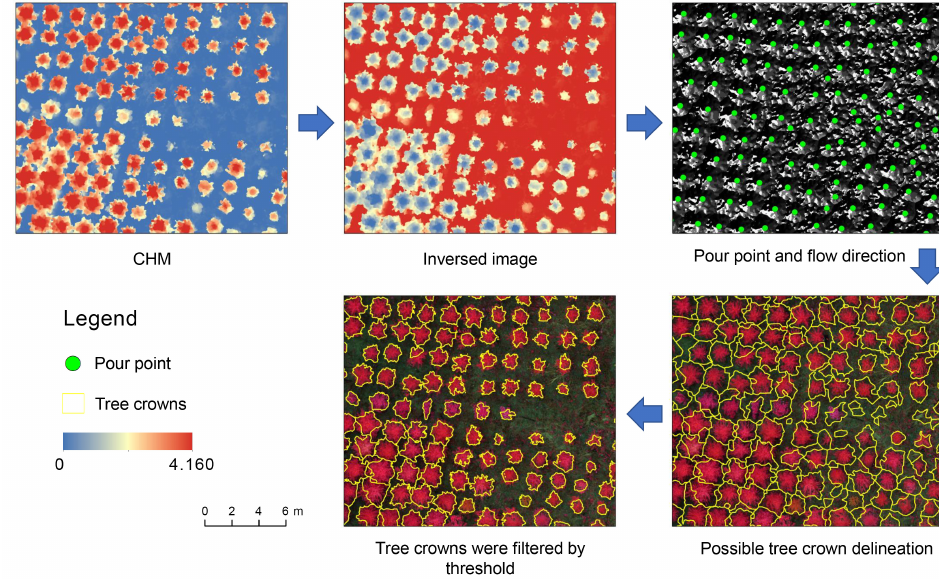
Figure 3. Overview of workflow for individual tree crown detection using Marker-controlled water- shed segmentation (MCWS) algorithm (using CHM as an example).